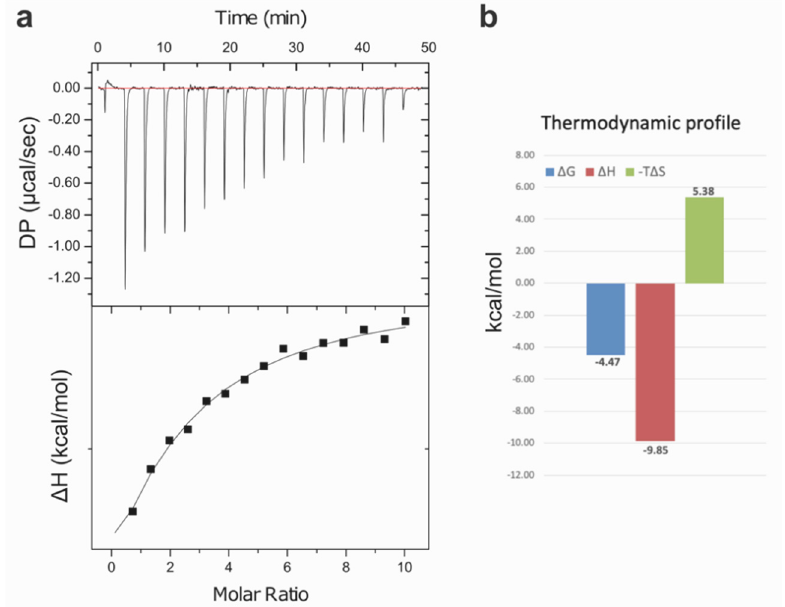
Figure 3. Isothermal Titration Calorimetry analysis ( a ) Example of a titration profile for H C /E with the GD1a-oligosaccharide. Top: raw data from the titration at 25 °C (differential power in µcal/s dispersed over time). Bottom: enthalpy of binding (kcal/mol) for each injection plotted against the protein:ligand molar ratio. Data were analysed with a single-site binding model least-squares-fit, resulting with K D = 530 µM (±40.0) ( b ) Binding free energies ( Δ G), enthalpies ( Δ H) and entropies ( Δ S), in kcal/mol, derived from 3 titrations with the GD1a-oligosaccharide.